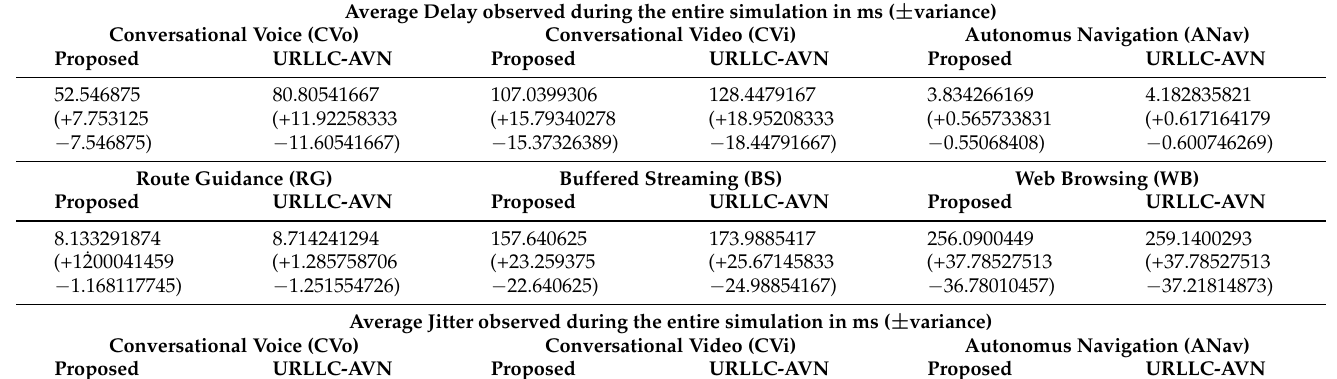
Table 6. The average evaluation results achieved from each scheme during the 24-h simulation. Average Delay observed during the entire simulation in ms ( ± variance) Conversational Voice